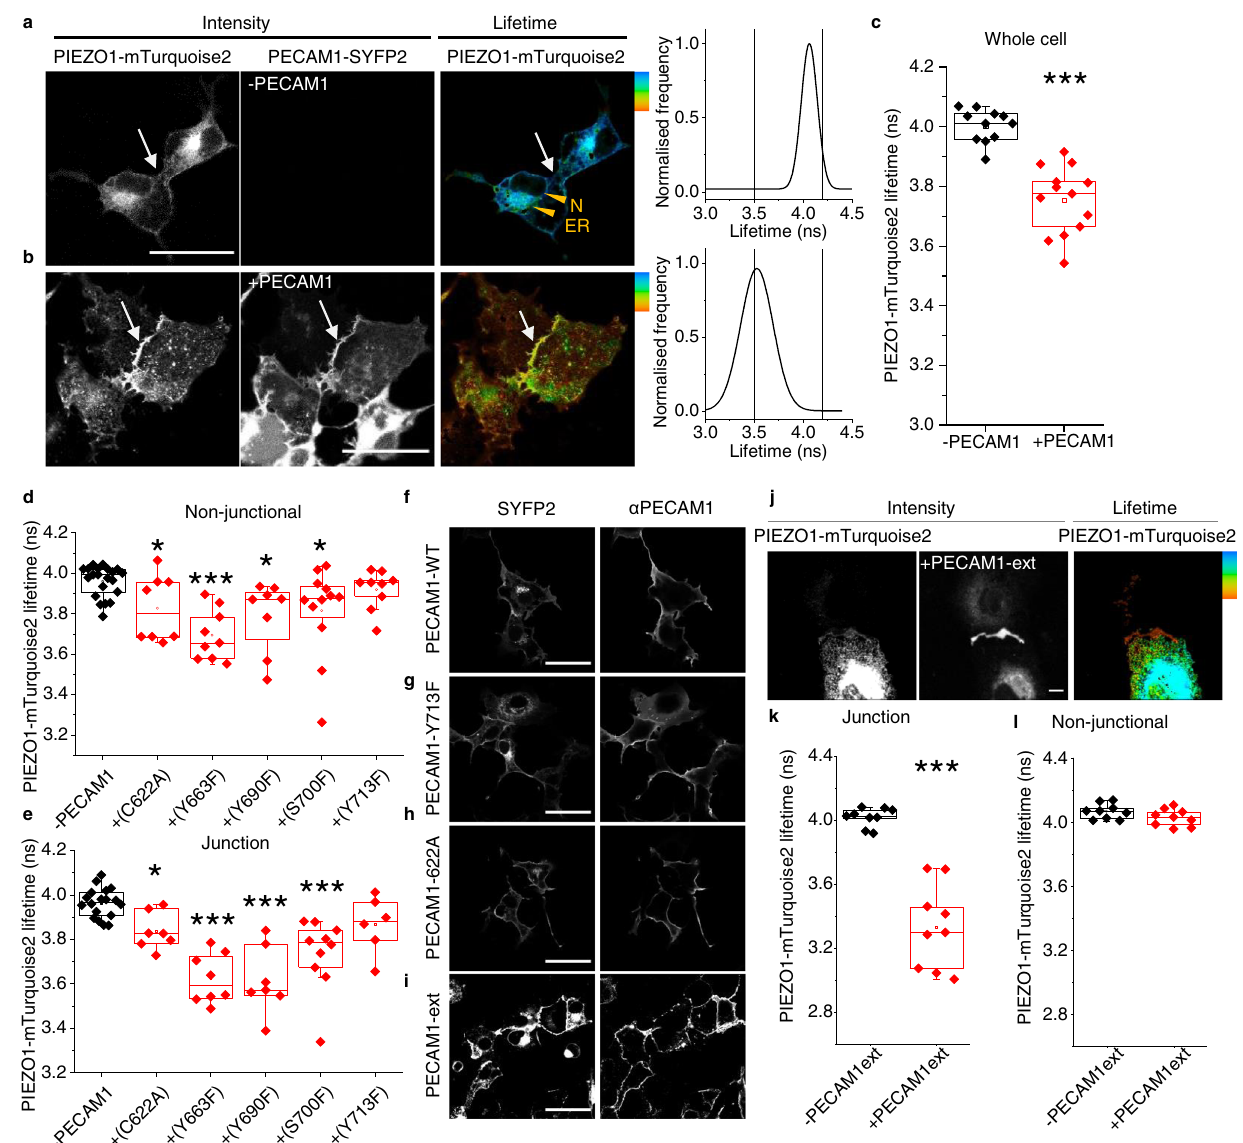
Fig. 4 PECAM1 drives PIEZO1 to cell-cell junctions. Data are for non-permeabilised COS-7 cells expressing human PIEZO1-mTurquoise2 with human PECAM1-SYFP2. a – l FRET/FLIM studies. a PIEZO1-mTurquoise2 alone. The intensity image in which white is high intensity and lifetime image calibrated to the rainbow scale (3.5 – 4.2 ns). The white arrows point to a region of cell-cell contact and the orange arrowheads nucleus (N) and endoplasmic reticulum (ER). The graph on the right is the lifetime distribution with the limits of the rainbow scale indicated by vertical lines. b Similar to a except PIEZO1- mTurquoise2 with PECAM1-SYFP2 ( + PECAM1). a , b Scale bars, 50 µ m. c Box plot presentation of summary data of the type shown in a and b , showing peak lifetime for the entire cell (Whole cell). n = 4 independent experiment repeats for PIEZO1-mTurquoise2 alone ( − PECAM1, black) and PIEZO1- mTurquoise2 plus PECAM1-SYFP2 cells ( + PECAM1, red). *** P = 3.16 ×10 − 5 . The superimposed data points are average lifetimes for different images, − PECAM1 ( N = 11) and + PECAM1 ( N = 13). d – h Data are for COS-7 cells expressing PIEZO1-mTurquoise2 only ( − PECAM1) or co-expressing PIEZO1-mTurquoise2 and PECAM1-SYFP2 in which PECAM1 was mutated at the indicated amino acid residue. Box plot presentations of FRET/FLIM peak lifetime data measured at: d Non-junctional (intracellular) regions (* P C622A = 0.0381,*** P Y663F = 5.98 ×10 − 4 ; * P Y690F = 0.0431, * P S700F = 0.02136, P = 0.13532); e Cell-cell junction regions (* P = 0.014, *** P = 3.56 ×10 − 4 , *** P = 7.76 ×10 − 4 , *** P = 2.07 ×10 − 4 , P = 0.1024). Y713F C622A Y663F Y690F S700F Y713F Data are for n = 3 independent experiment repeats. The superimposed data points are average lifetimes for different images, − PECAM1 ( N non junctional = 21 and N junctional = 18), + C622A ( N non junctional = 8 and N junctional = 7), + Y663F ( N non junctional = 9 and N junctional = 8), + Y690F ( N non junctional = 8 and N = 7), + S700F ( N = 12 and N = 10), + Y713F ( N = 9 and N = 6). Confocal images showing sub cellular junctional non junctional junctional non junctional junctional distribution of f wild-type (WT) PECAM1, g Y713F and h C622A as SYFP2 fl uorescence and after immunostaining using antibody to PECAM1 extracellular domain ( α PECAM1) in non-permeabilised cells. Images are representative of n = 3 independent experiments. Scale bars, 50 µ m. i – l Data are for COS-7 cells expressing PIN-G-tagged N-terminal PECAM1-ex-SYFP2 alone (PECAM1-ex) or with PIEZO1-mTurquoise2. i Confocal image showing sub cellular distribution of PECAM1-ex. j Intensity images and lifetime image calibrated to the rainbow scale indicated at the top right corner (3.5 – 4.2 ns). Scale bar, 50 µ m, applies to all images. Box plot presentations of FRET/FLIM peak lifetime data measured at: k Cell-cell junctions (*** P = 4.12 ×10 − 4 ); l Non- junctional regions ( P = 0.18533). Data are for n = 3 independent experiment repeats. The superimposed data points are average lifetime values junctions ( − PECAM1ext, N = 9 and + PECAM1ext, N = 9) and non-junctions ( − PECAM1ext, N = 9 and + PECAM1ext, N = 9) from separate